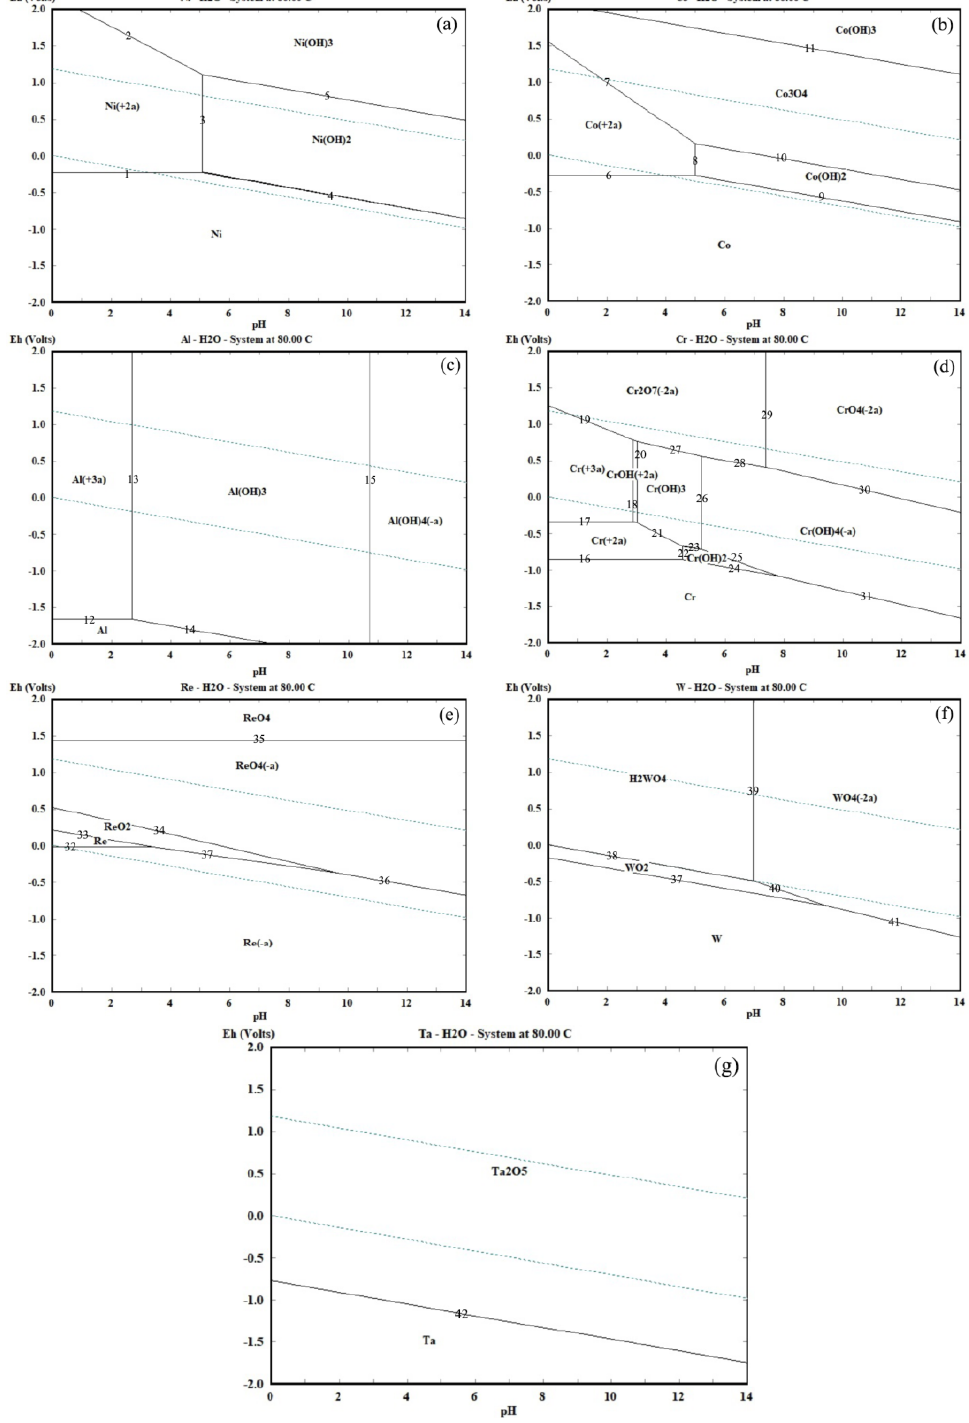
Figure 2. Eh-pH diagram of rare metals in the leaching and separation process at 80 °C. (( a )—Ni;